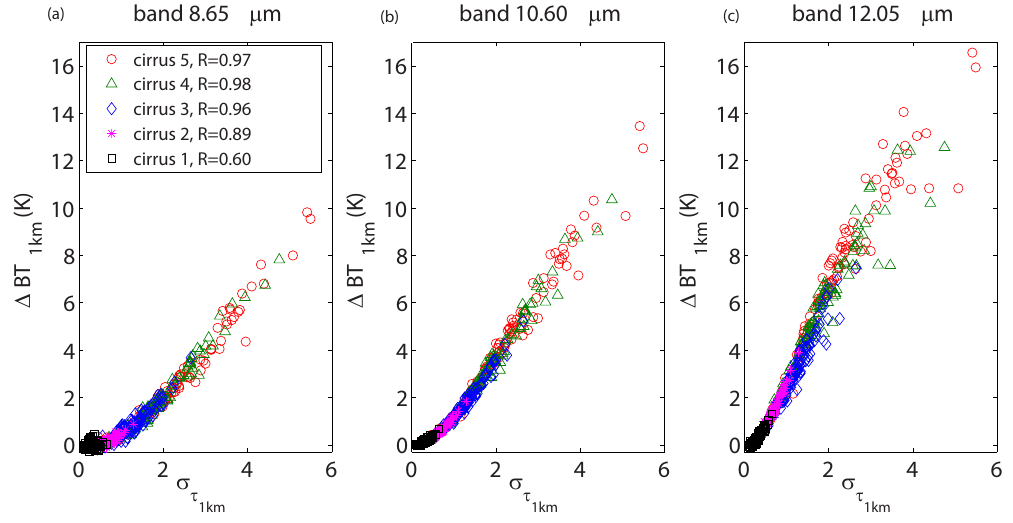
Figure 12. Brightness temperature differences, 1 BT 1km , viewed at the nadir as a function of the optical thickness standard deviation σ τ for different cirri presented in Table 1. R represents the average correlation coefficient over the three bands.